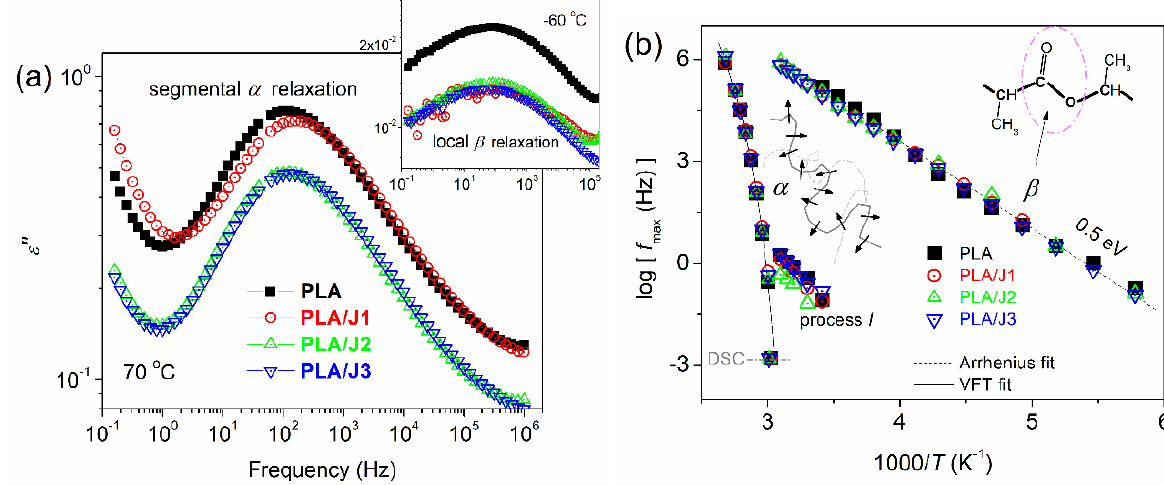
Figure 3. ( a ) Comparative DS spectra for the imaginary part of dielectric permittivity, ε ”, (dielectric loss) against frequency at 70 ◦ C and (inset) − 60 ◦ C, representative of the segmental and local dynamics. ( b ) Molecular dynamics (time scale) map for all samples. The inset schemes of ( b ) describe the origins of the recorded processes. The additional process I was necessary for the fitting- analysis.